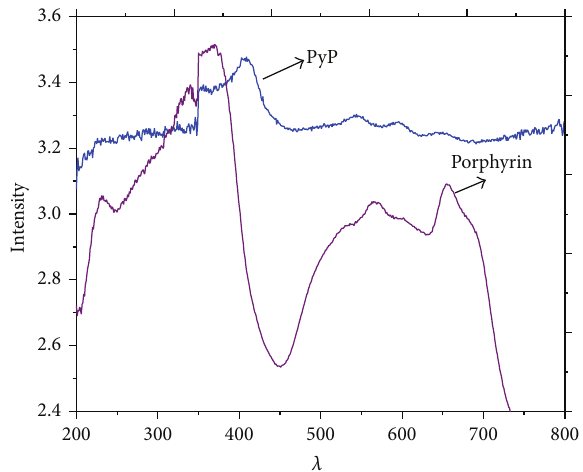
Figure 2: Solid-state absorption spectra PyP (blue), 1 (purple) as powders using a praying mantis diffuse reflectance